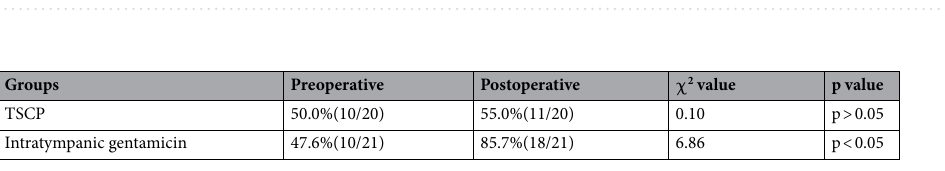
Table 4. Abnormal rate of cVEMP pre- and post-operatively in TSCP and intratympanic gentamicin patients.